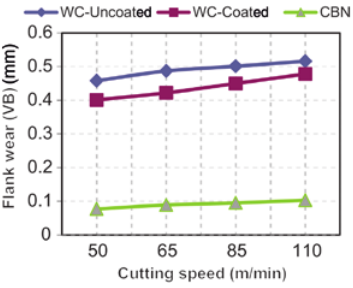
Figure 4: Cutting speed-flank wear relationship in the machining of 10% B C-reinforced 4